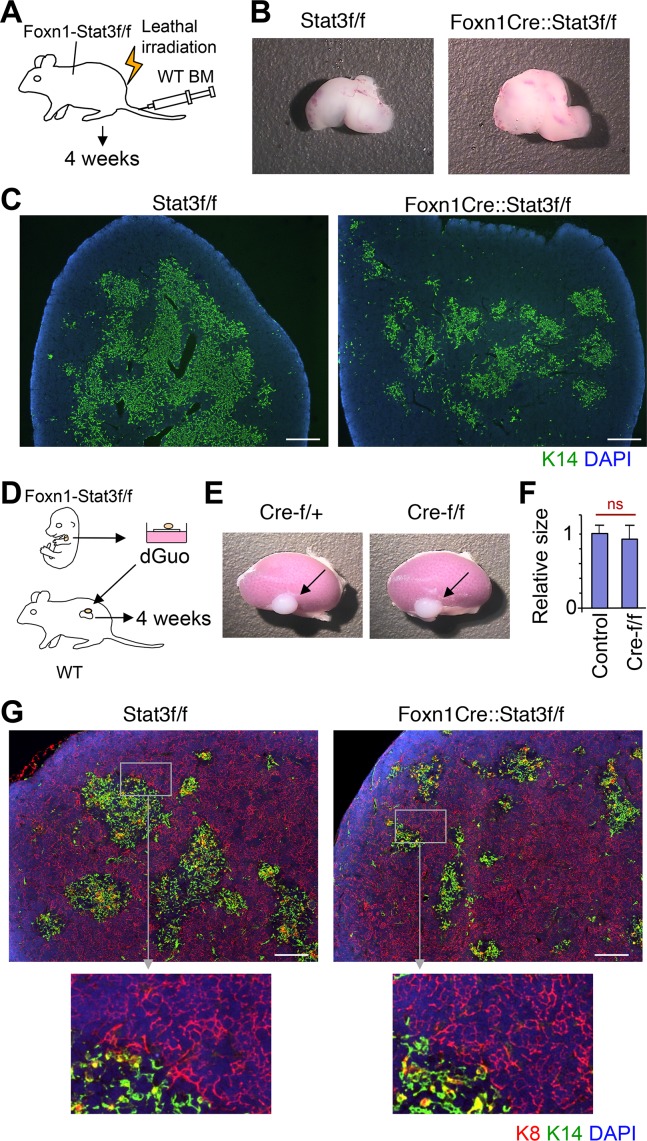
Regenerative potential of cTECs was not affected in Foxn1-Stat3-CKO mice.(A) Experimental procedure for (B) and (C). Foxn1-Cre::Stat3-f/f mice were lethally irradiated and then rescued by bone marrow transplantation from wild type mice. After 4 weeks, mice were sacrificed and thymic tissue was examined. (B) Macroscopy of the thymus 4 weeks after hematopoietic stem cell transplantation. (C) Cryostat sections of the thymus were stained with anti-K14 antibody (green) and counterstained with DAPI (blue). Scale bars: 400 μm. (D) Experimental design for data presented in panels (E) and (F). Foxn1-Cre::Stat3-f/f fetal thymic lobes (15 dpc) were cultured in vitro for 6 days in the presence of deoxyguanosine and subsequently transplanted under kidney capsule of wild type mice. After 4 weeks, mice were sacrificed and thymic grafts were examined. (E) Gross anatomical analysis of the thymic grafts 4 weeks after grafting into C57BL/6 wild type recipients. (F) Comparison of maximum cross-section area of thymic grafts of control (containing Cre-f/+ and f/f, n = 4) and Foxn1Cre::Stat3f/f mice (n = 4). (G) Cryostat sections of thymic grafts were stained with anti-K8 (red) and anti-K14 antibody (green). Sections were counterstained with DAPI (blue). Scale bars: 200 μm.